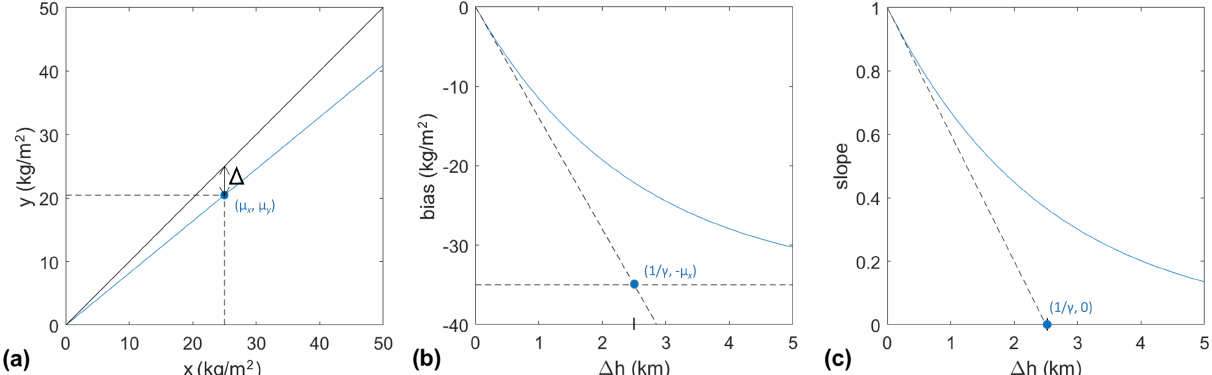
Figure 1. Illustration of the variation in IWV as a function of height in the case of an idealized moisture profile with exponential vertical decay with a rate γ = 4 × 10 − 4 m − 1 (scale height 1 /γ = 2 . 5km): (a) y = x · exp ( − γ(cid:49)h) as a function of x for a fixed (cid:49)h > 0; (b) bias, (cid:49) = µ y − µ x , as a function of (cid:49)h (Eq. 3); and (c) slope, α , as a function of (cid:49)h (Eqs. 4a and 4b). The slanted dashed lines in panels (b) and (c) represent the thin layer approximations (rightmost sides of Eqs. 3, 4a and 4b, respectively).